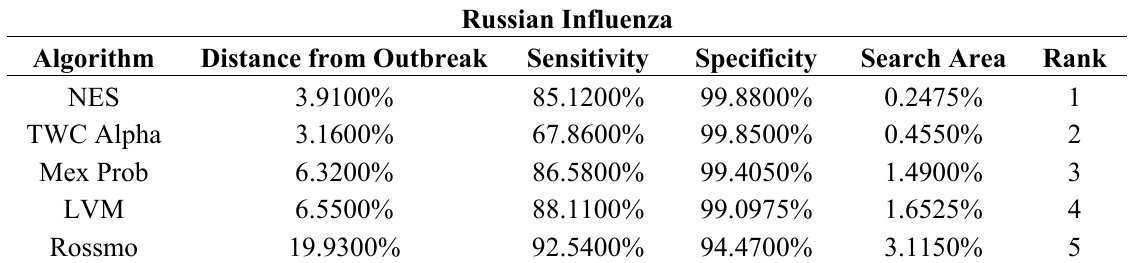
Table 4. Russian influenza results.